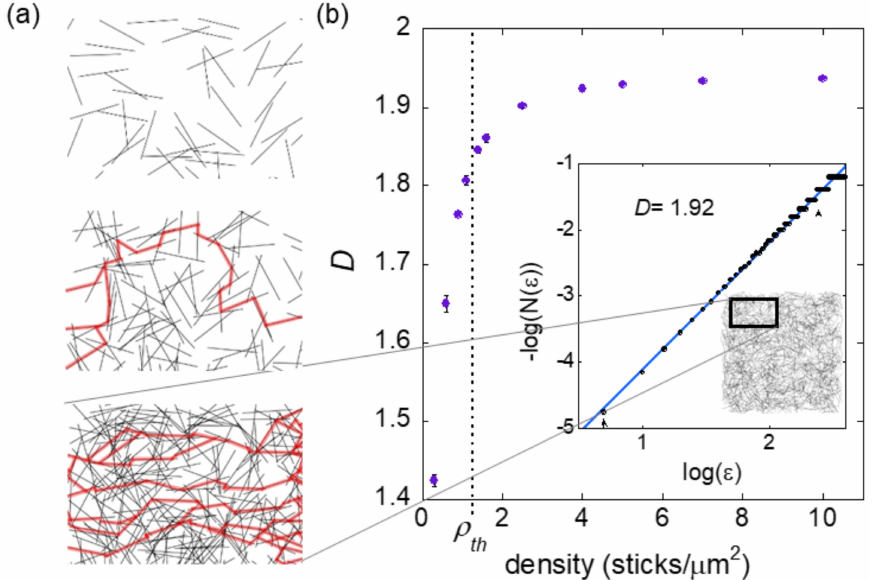
Figure 3. ( a ) Details of simulated networks at densities of 0.6, 1.4, and 4.0 (top to bottom) with any percolated paths highlight in red. ( b ) Fractal dimension, D , of simulated CNT thin film networks as a function of density. The D value changes rapidly near the percolation threshold ( ρ th = 1.172 sticks/ µ m 2 ) indicated with a dashed line. Error bars indicate the variance of D value for three networks at each density. The inset shows the box-counting plot resulting from fractal analysis for a network with a density of 4.0 sticks/mm 2 . The linearity of the plot indicates fractal scaling with the slope of the best-fit line, which determines the fractal dimension D (value given for plot